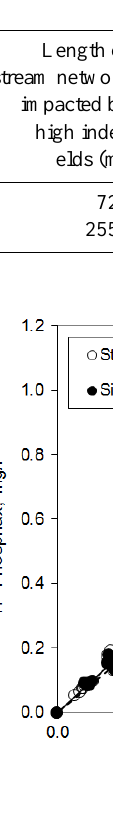
Figure 3. Quality control check on the Phosphax colorimetry pro- cess (closed symbols) and the Sigmatax sampling followed by the Phosphax colorimetry